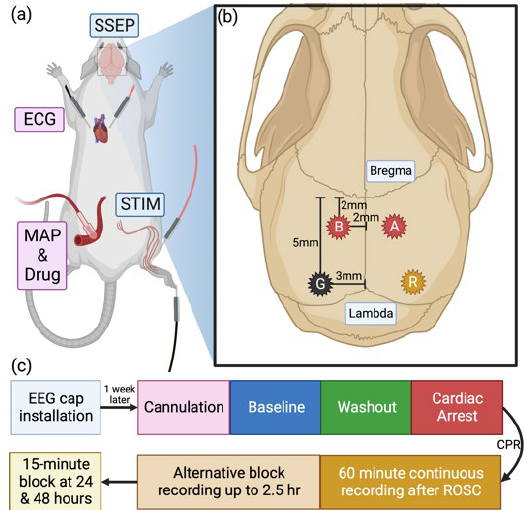
Figure 1. Experiment protocol. ( a ) Placements for arterial catheter, somatosensory evoked potential (SSEP) stimulating electrodes, and electrocardiogram (ECG) recording electrodes. ( b ) electroen- cephalogram (EEG)/SSEP recording electrode placements. Electrodes A and B were placed on the primary somatosensory cortex hindlimb regions (anterior/posterior (AP): − 2; midline/lateral (ML): ± 2). Ground (G) and reference (R) electrodes were placed on top of the posterior parietal lobe (AP: − 5; ML: ± 3). ( c ) Experimental timeline. Created with